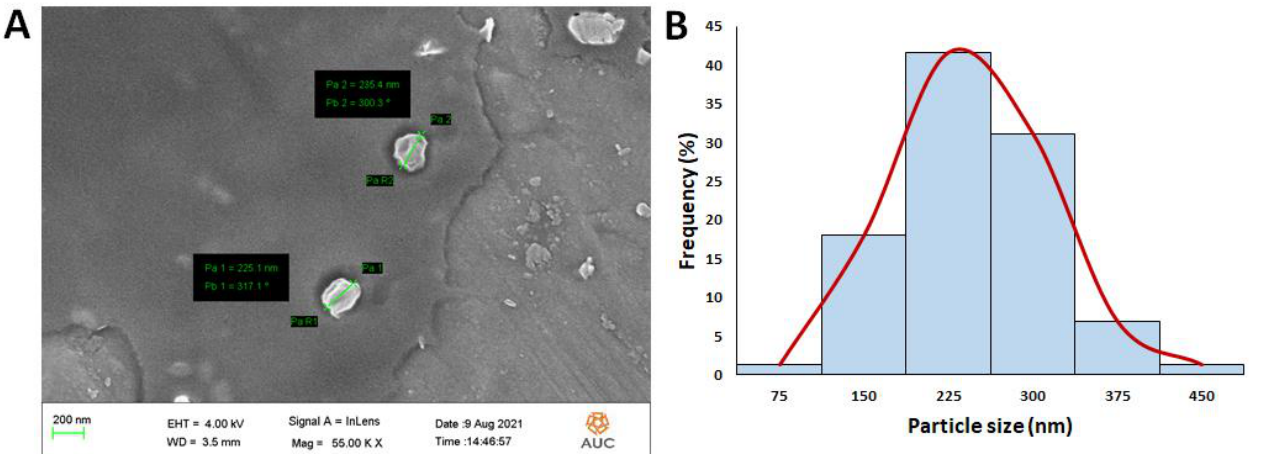
Figure 2. Particle size distribution of the prepared HARF–HPßCD/AA@PLGA-PEG NPs using DLS analysis.